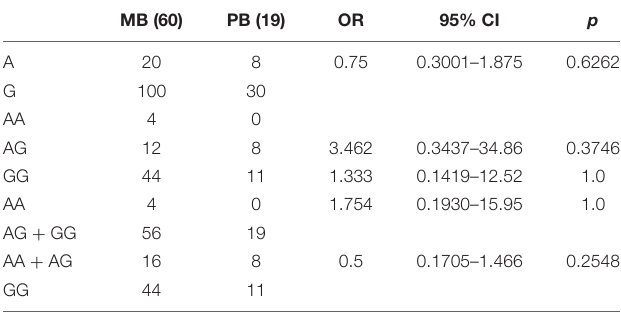
TABLE 5 | Allele and genotype distribution of polymorphisms rs1718119 in the P2RX7 gene between multibacillary and paucibacillary